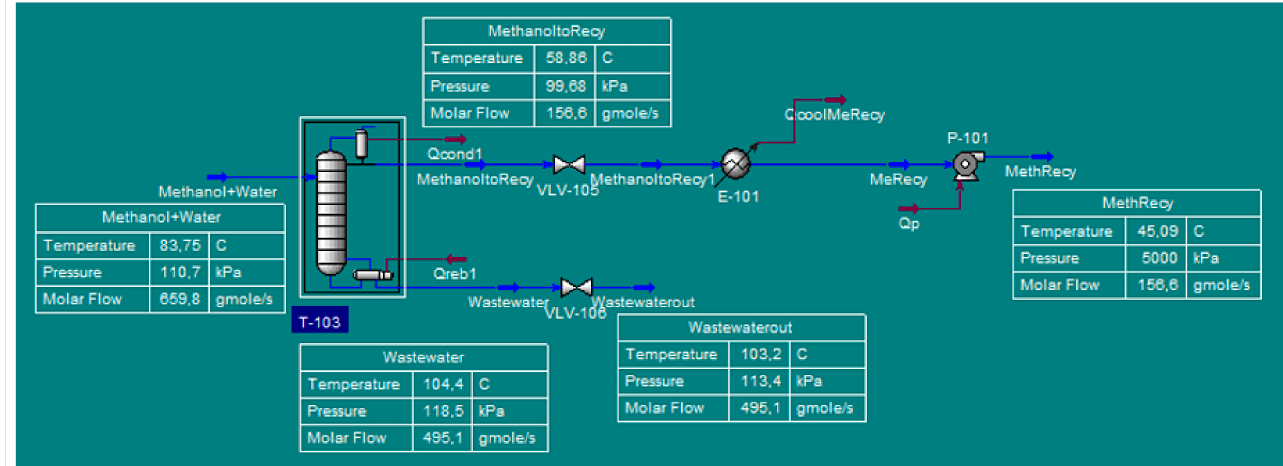
Figure 1. Methanol purification process